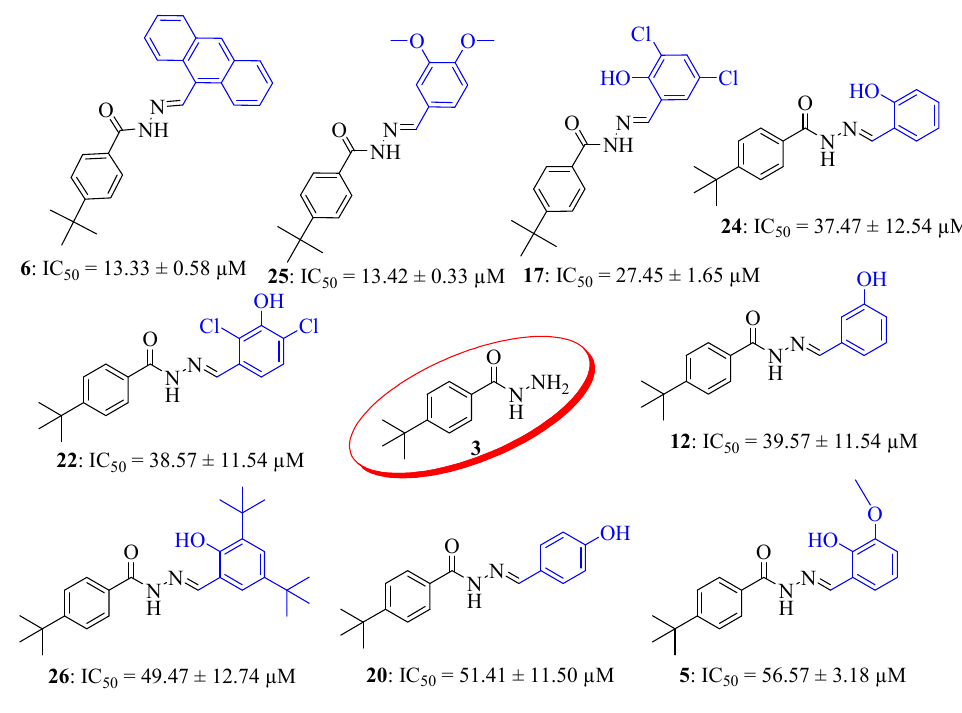
Figure 5. Active inhibitors of the synthesized series. Table 8. Docking scores (S) and Interactions Detail of the selected active compounds ( 9 – 11 , 16 , 18 , 19 , 22 , 24 , and 25